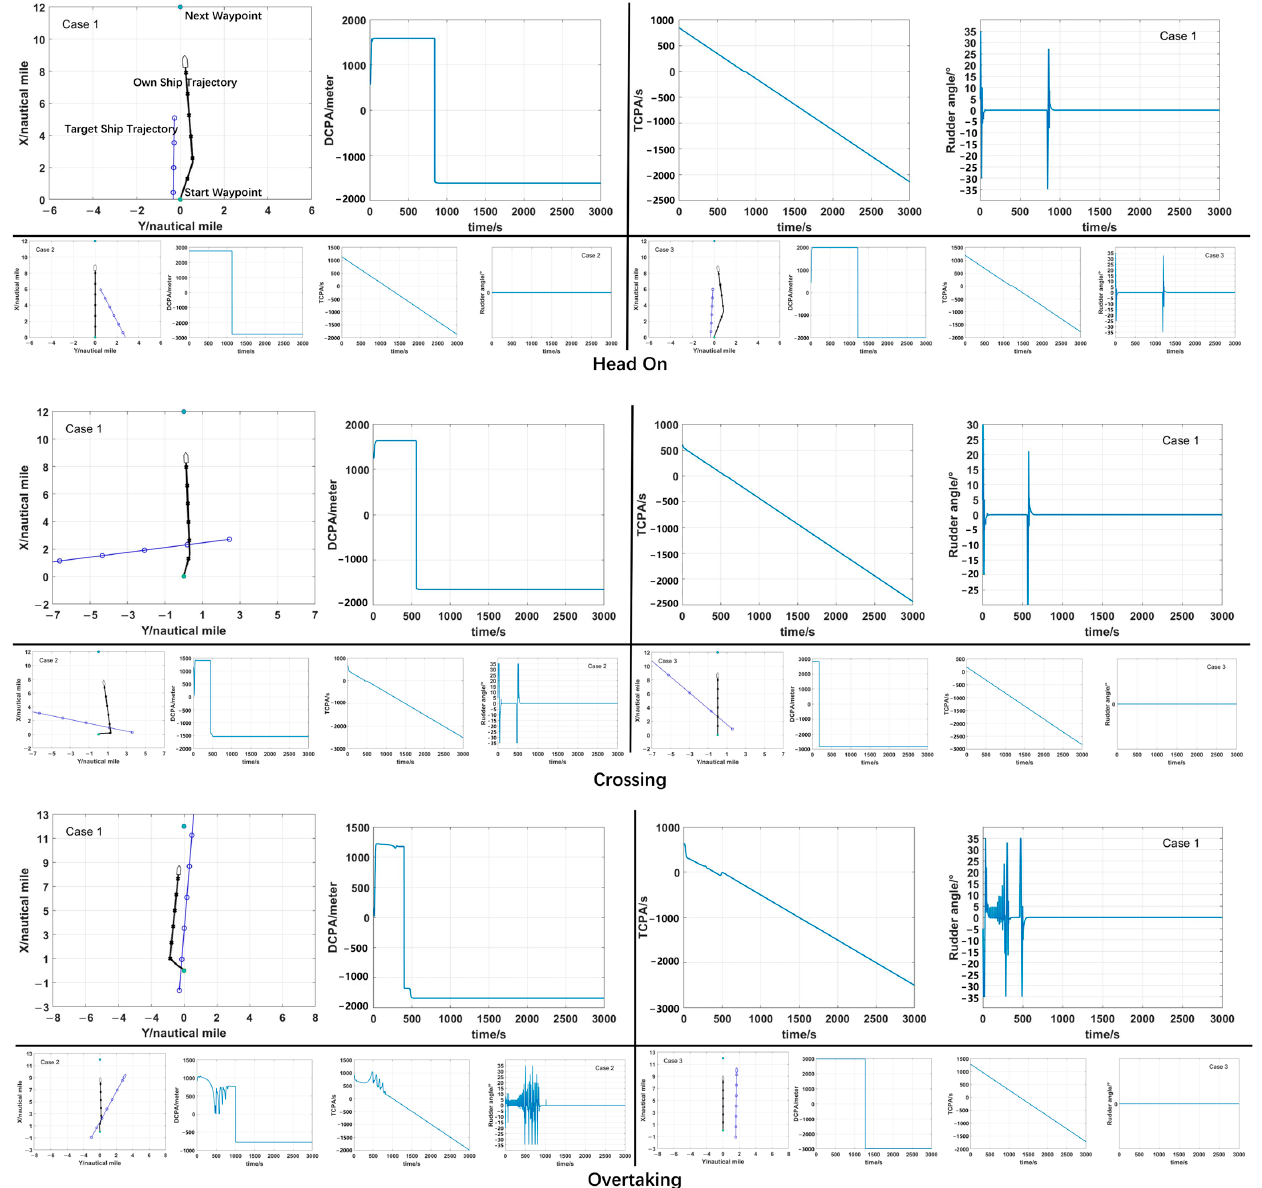
Figure 15. Test samples in generated virtual scenarios of single target ship encounter. There are 3 types of encounters (heading on, crossing and overtaking), in each 3 cases of trajectory results are shown (case 1 is in larger graphs, case 2 and 3 in the smaller), DCPA, TCPA and rudder angle changings are also added. Table 7. Test results in head-on scenarios. Test Results (Head-On)